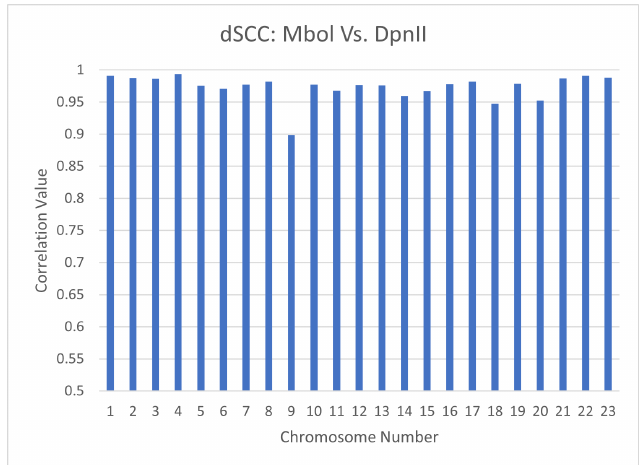
Figure 15. dSCC computed between the outputs of CBCR from the Mbol and DpnII restriction enzymes at 1mb